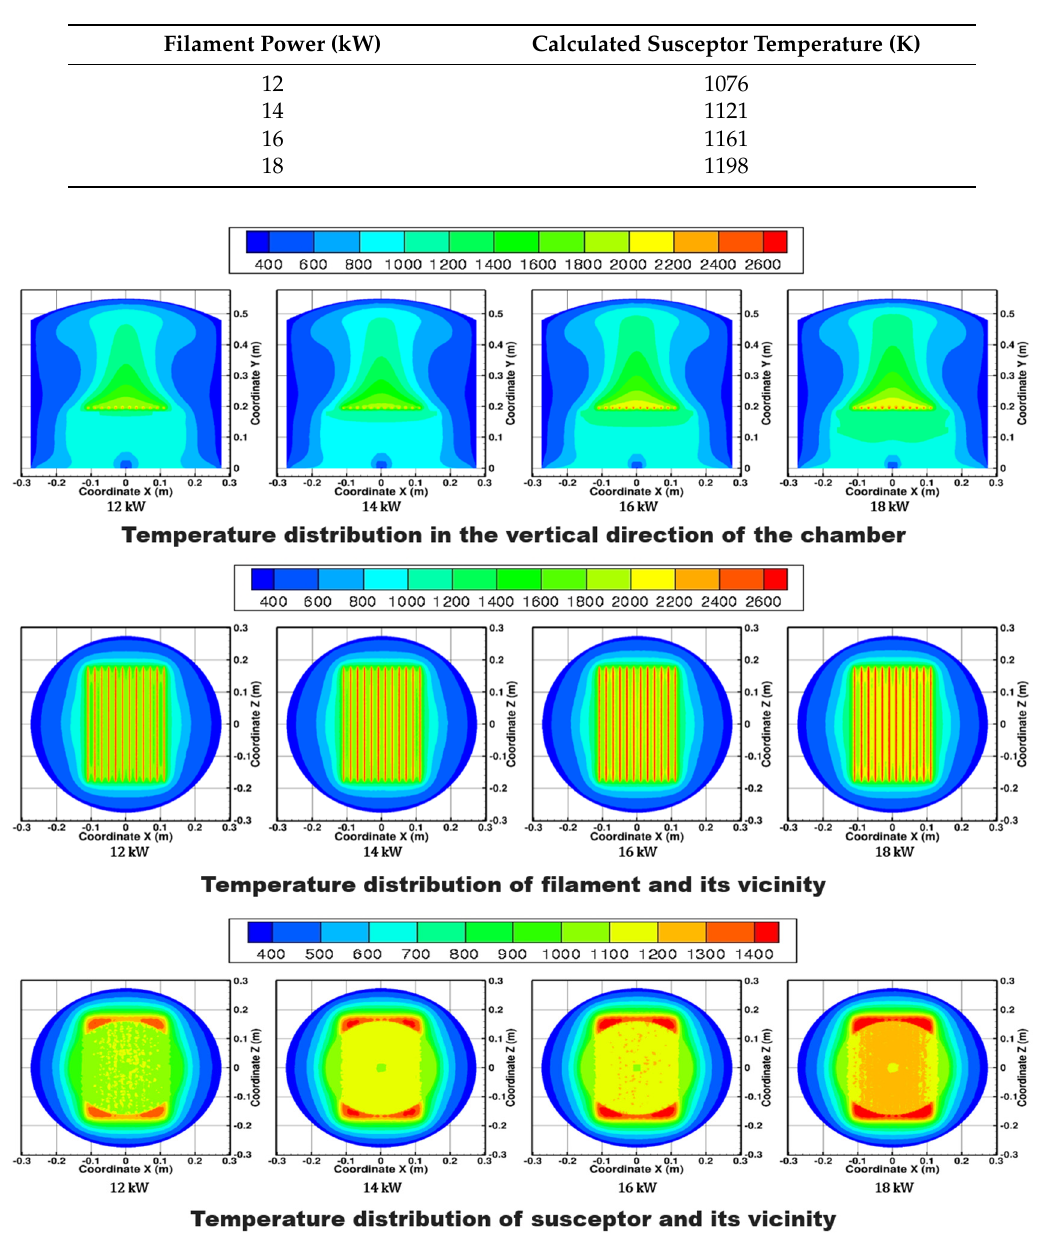
Table 3. Calculated temperatures at the center of the susceptor according to applied power.